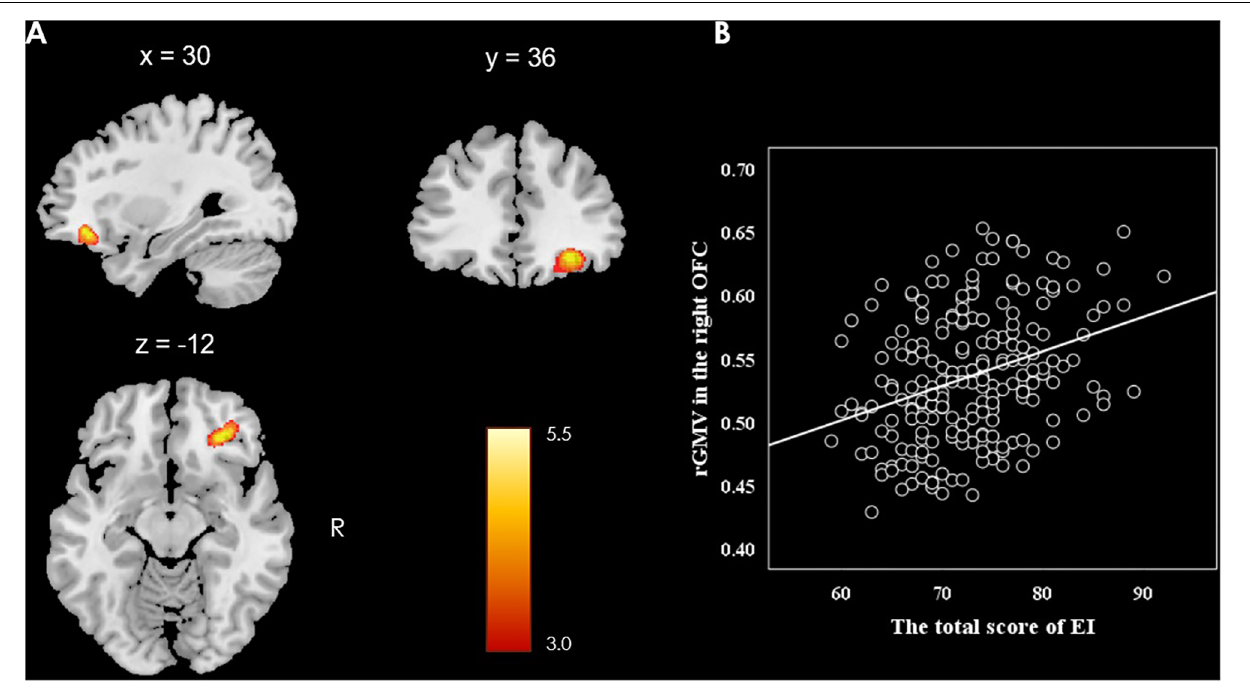
FIGURE 1 | Brain regions of positive correlation between GMV and EI. (A) The right OFC exhibited significant positive correlation with total score of EI as measured by the SSREIS (shown at t > 3 for visualization purposes), gender, age, general intelligence and total GMV were regressed out. (B) Scatter plots showed the correlation between EI and rGMV in the right OFC ( r = 0.33, p < 0.001).